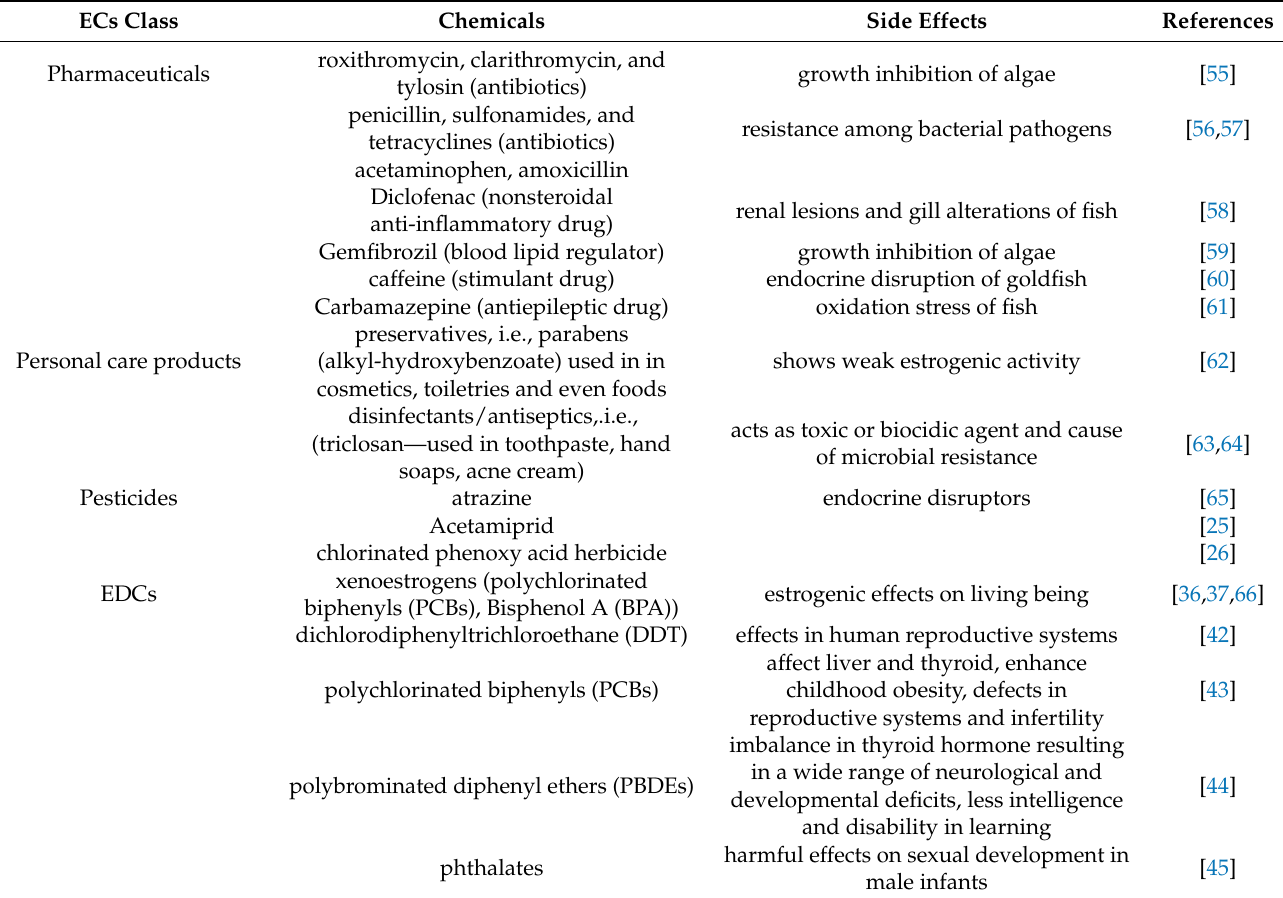
Table 1. Classifications and side effects of the